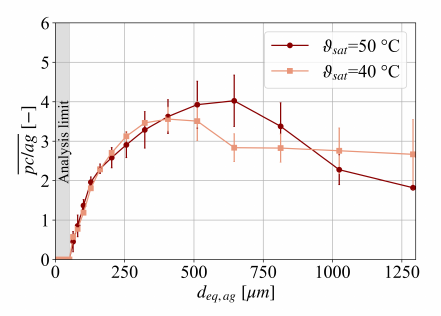
Figure 10. The average number of primary crystals per agglomerate ( pc / ag ) as function of agglom- erate size for ϑ sat = 40 ◦ C in bright and ϑ sat = 50 ◦ C in dark red. The error bars are calculated according to the three replicated crystallizations for each saturation temperature.